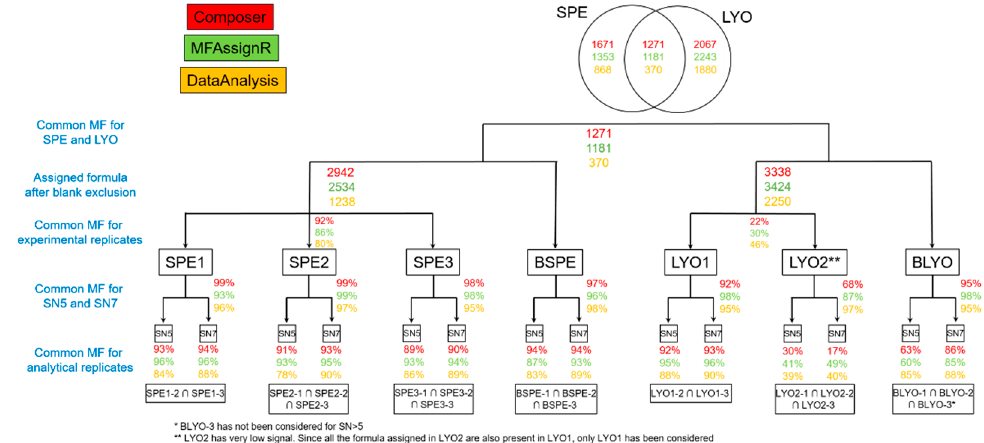
Figure 4. Percentage of MFs (molecular formulas) in common for each sample, considering only the number of MFs (weighted percentage). Colors represent the data treatment applied for the three software programs considered in this work: red for Composer, green for MFAssignR, and yellow for DataAnalysis. The percentages in the first bottom line represent the common MFs for analytical replicates; those in the second line represent the common MFs for the S/N 5 (signal to noise) and S/N 7 ratios; and those in the third line represent the common MFs for the experimental replicates. The fourth line reports the number of MFs obtained after the exclusion of blank MFs, while the fifth line presents a comparison between SPE and LYO.